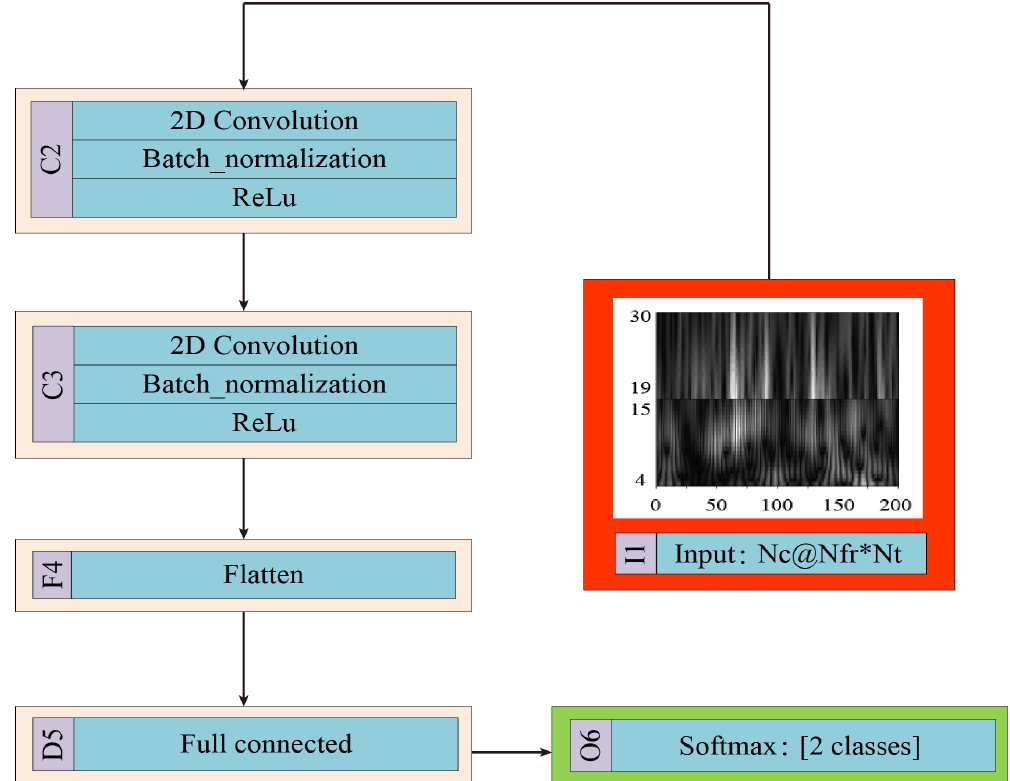
Figure 4. The six-layer SCNN framework for MI